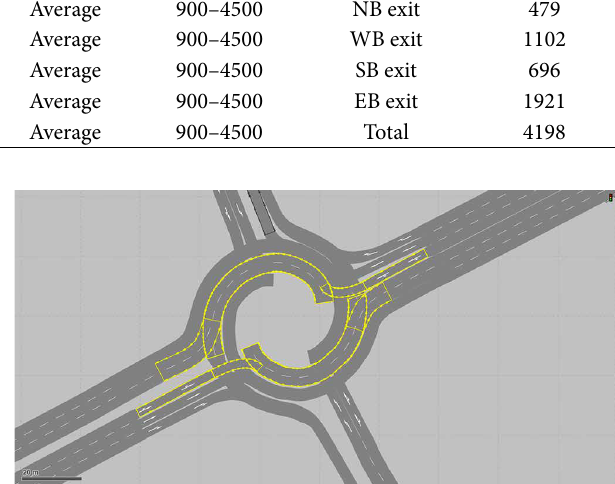
Figure 5: Layout and geometry of the modified rotor roundabout (alternative design